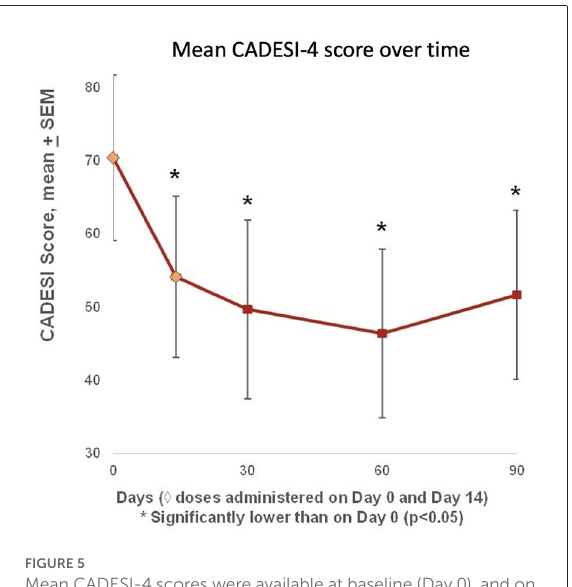
FIGURE5 Mean CADESI-4 scores were available at baseline (Day 0), and on Days 14, 30, 60, and 90. Scores began improving after the first treatment, and were significantly lower than baseline on Days 14, 30, 60, and 90, with a nadir on Day 60 and a slight increase from Day 60 to Day 90. Compared with baseline, six out of seven dogs (86%) had improved CADESI-4 scores on Day